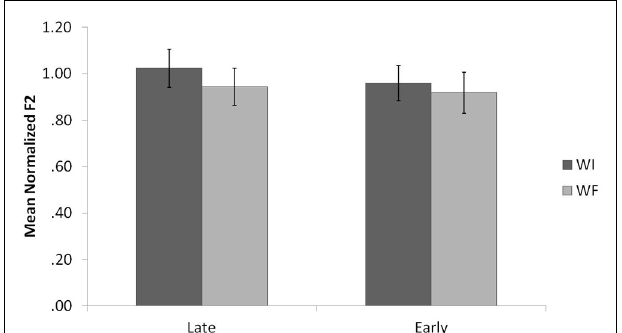
FIGURE 3 | Mean normalized F2 values by context for Late Bilinguals and Early Bilinguals for Spanish. Error bars refer to standard errors.